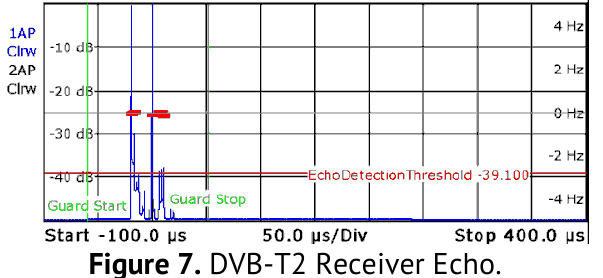
Figure 7. DVB-T2 Receiver